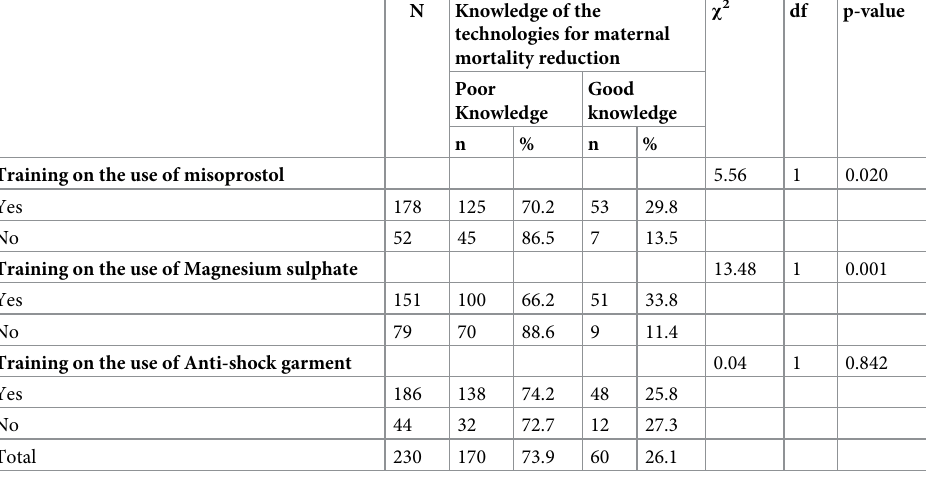
Table 3. Association between training on the use of the technologies (Misoprostol, MgSO 4 and NASG) and knowl- edge of the technologies for maternal mortality reduction.